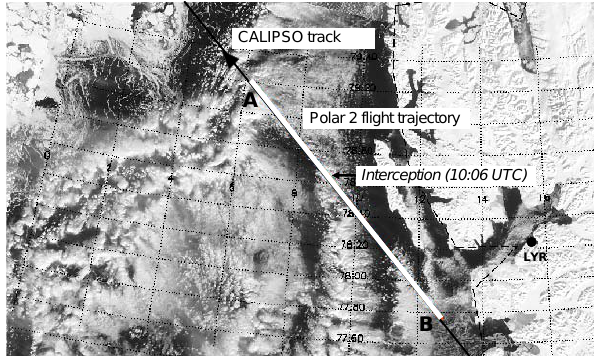
Fig. 1. Satellite picture taken on 9 April 2007 at 10:06UTC by MODIS (visible channel). The Polar-2 flight trajectory between the way points A and B is superimposed to the CALIPSO/CLOUDSAT overpasses. The Polar-2 interception point with the satellite track is indicated. LYR is the location of